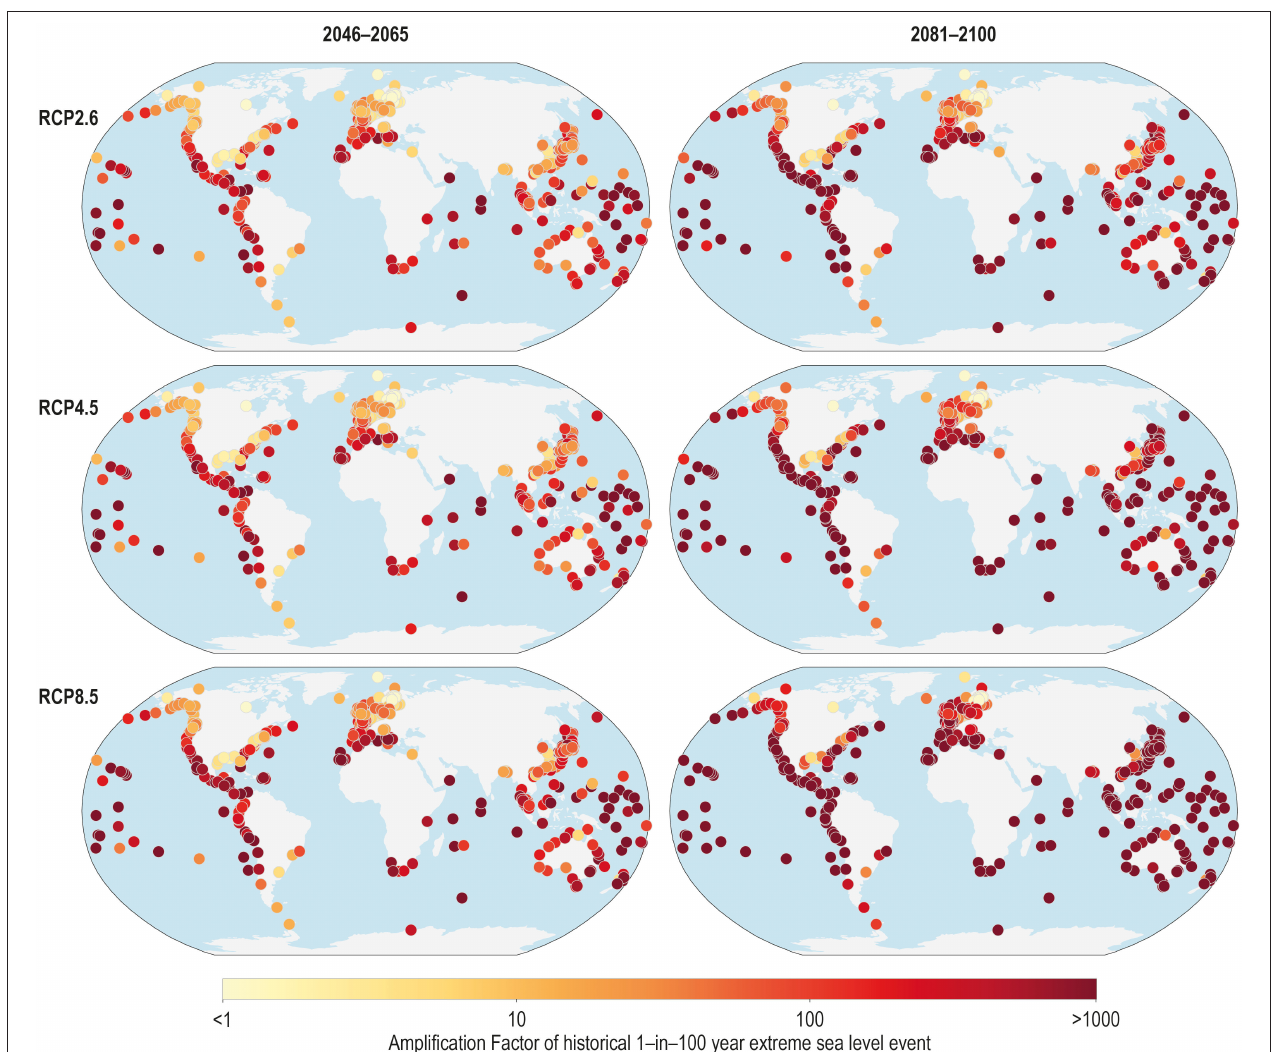
FIGURE 2 | Coastal extreme events due to melting glaciers and ice sheets causing sea level rise. The colours of the dots express the factor by which the frequency of extreme sea-level events increases in the future for events that historically have a return period of 100 years. Hence a value of 50 means that what is currently a 1-in-100-year event will happen every 2 years due to a rise in mean sea level. Source: Oppenheimer et al.